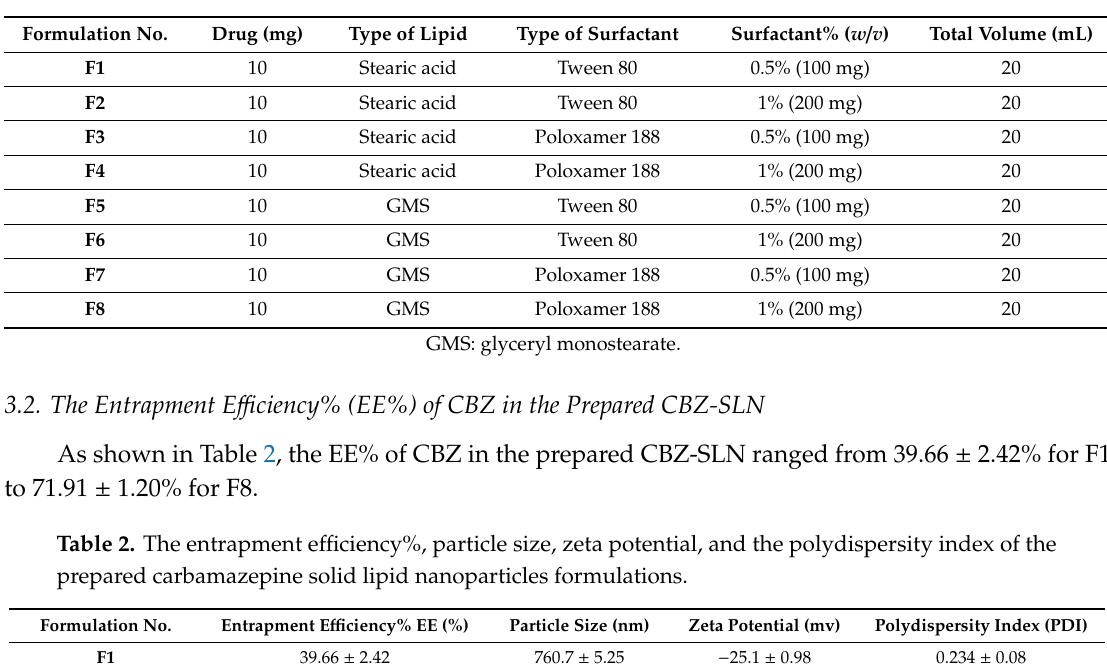
Table 1. The composition of carbamazepine solid lipid nanoparticles formulations.